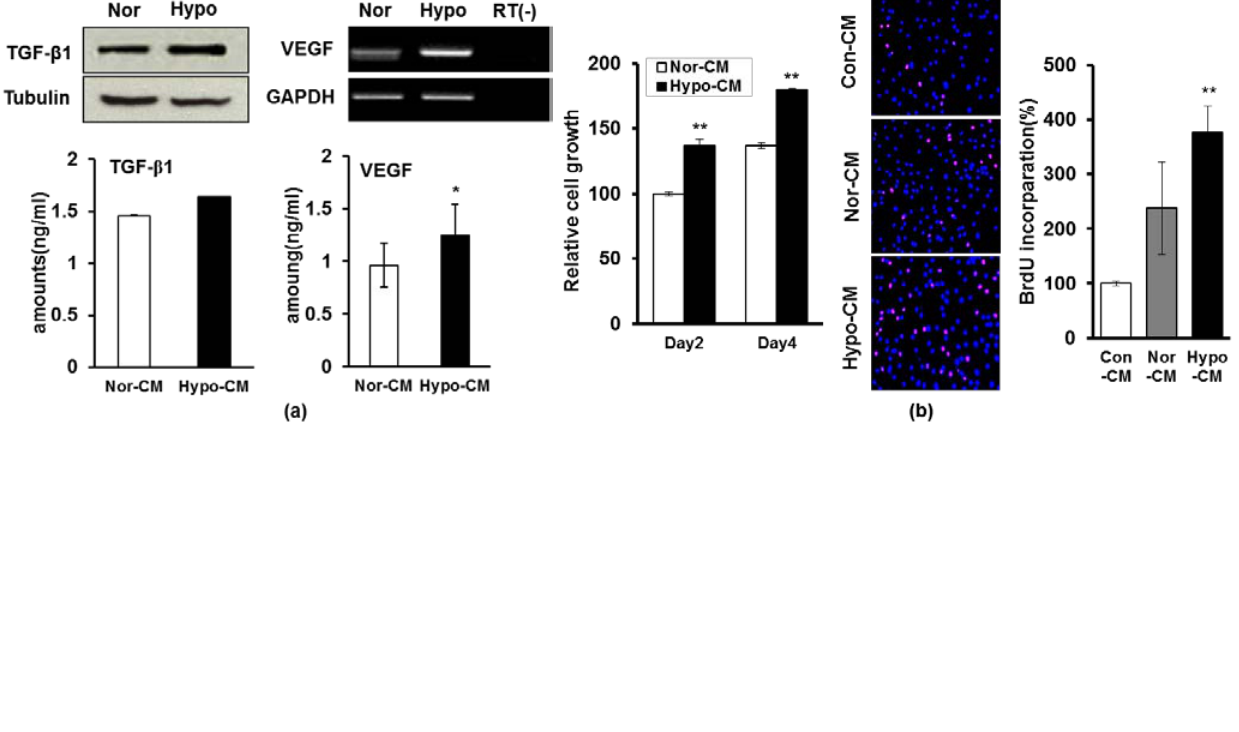
Figure 3. The effect of AF-MSC-hypoCM with paracrine factors on the proliferation and migration of human dermal fibroblast. ( a ) RT-PCR, western blot and ELISA assay was performed to determine the expression levels of paracrine factors (TGF-β1 and VEGF) from cells (AF-MSCs cultured under normoxic and hypoxic condition) and their conditioned media (AF-MSC-norCM and AF-MSC-hypoCM), showing the expression levels of TGF-β1 and VEGF in either cells or condition medium were increased in response to hypoxic condition; ( b ) The number of viable dermal fibroblasts was significantly increased when cultured in AF-MSC-hypoCM compared with in AF-MSC-norCM, indicated that AF-MSC-hypoCM causes the increases of DNA replication of fibroblasts, which was demonstrated by BrdU assay; ( c ) Micrographs of scratch-wound-closure assays following either AF-MSC-norCM or AF-MSC-hypoCM treatment. Dermal fibroblasts were synchronized by serum starvation, wounded, and treated with either AF-MSC-norCM or AF-MSC-hypoCM treatment for 24 h before being photographed. A significant increase in the migration of human dermal fibroblasts into the wound area was observed in response to AF-MSC-hypoCM treatment at 18 h after scratch injury. Arrows indicate the distance of wound, showing the decrease in AF-MSC-hypoCM treatment; ( d ) Effect of inhibition of TGF-β1 and VEGF on AF-MSC-hypoCM-induced migration of cells. AF-MSC-hypoCM-enhanced scratch-wound-closure and cell migration were significantly weakened by the inhibitors of TGF-β1 and VEGF, SB431542 and anti-VEGF, respectively; and ( e ) Quantitation of changes in gene expression of ECM molecules detected by real-time PCR after either AF-MSC-norCM or AF-MSC-hypoCM treatment. Data are expressed as the mean ± SD. * p < 0.05, ** p <